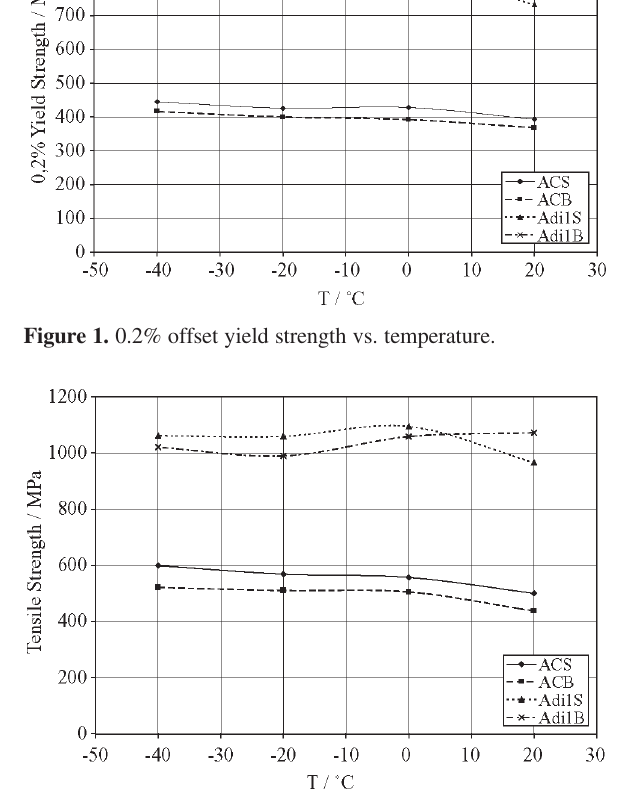
Figure 2. Tensile strength vs. temperature.